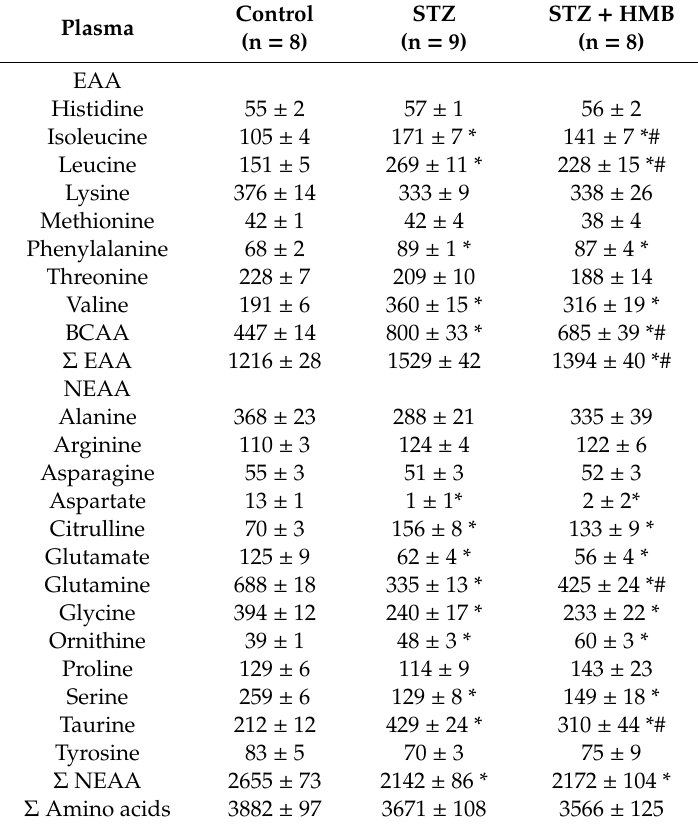
Table 3. Amino acid concentrations in